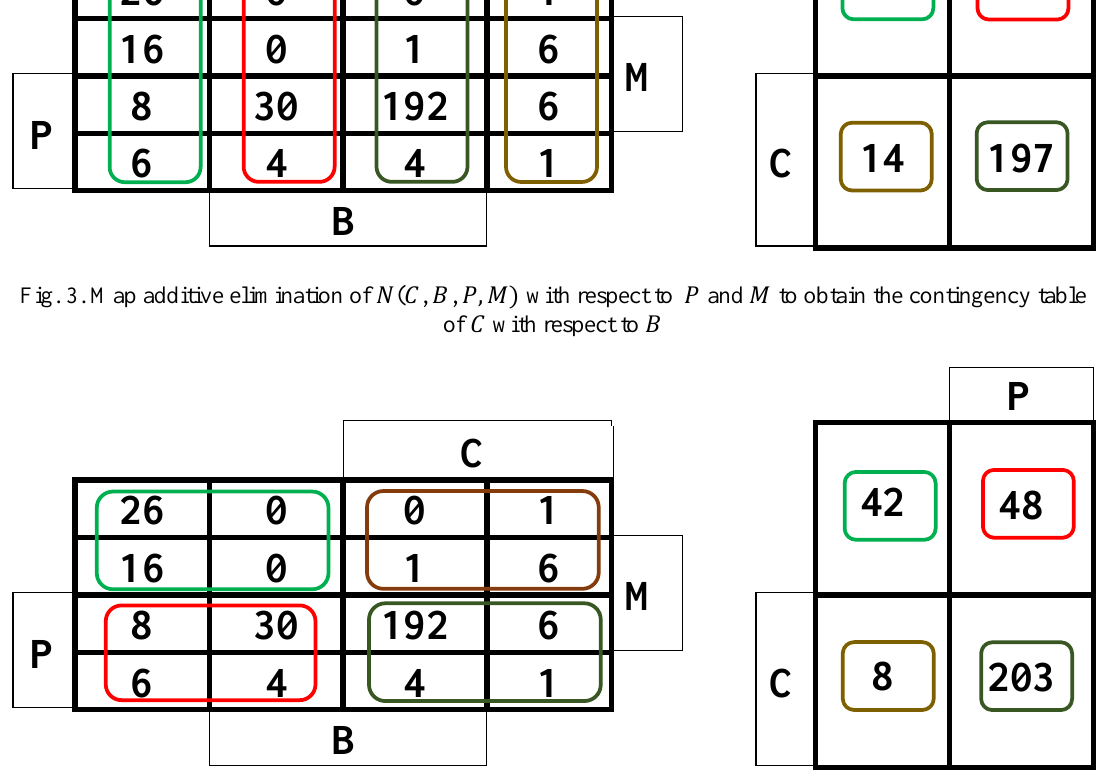
Fig. 4. Map additive elimination of 𝑁 ( 𝐶 , 𝐵 , 𝑃, 𝑀) with respect to 𝐵 and 𝑀 to obtain the contingency table of 𝐶 with respect to